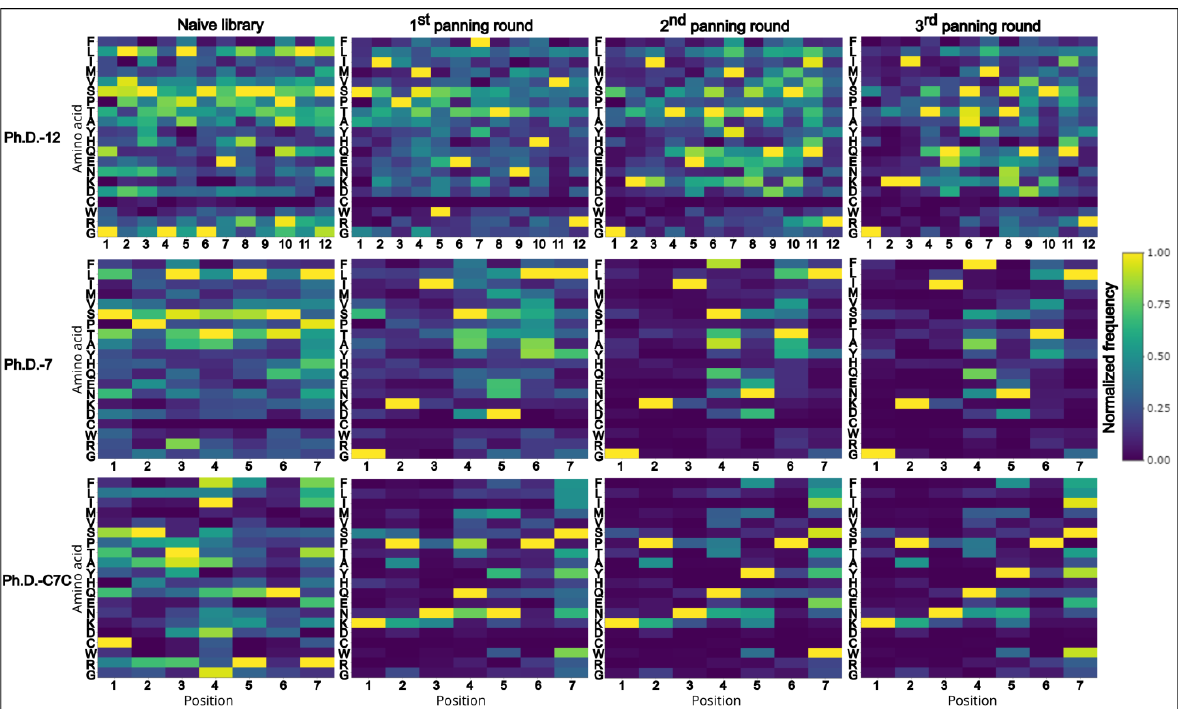
Figure 4. Heatmaps of normalized data from amino acid frequencies from the cleaned data (unique sequences without TUPs). On the x-axis positions of amino acids are plotted and on the y-axis the respective amino acids are listed in the following order (top to bottom): F, L, T, M, V, S, P, T, A, Y, H, Q, E, N, K, D, C, W, R, G.